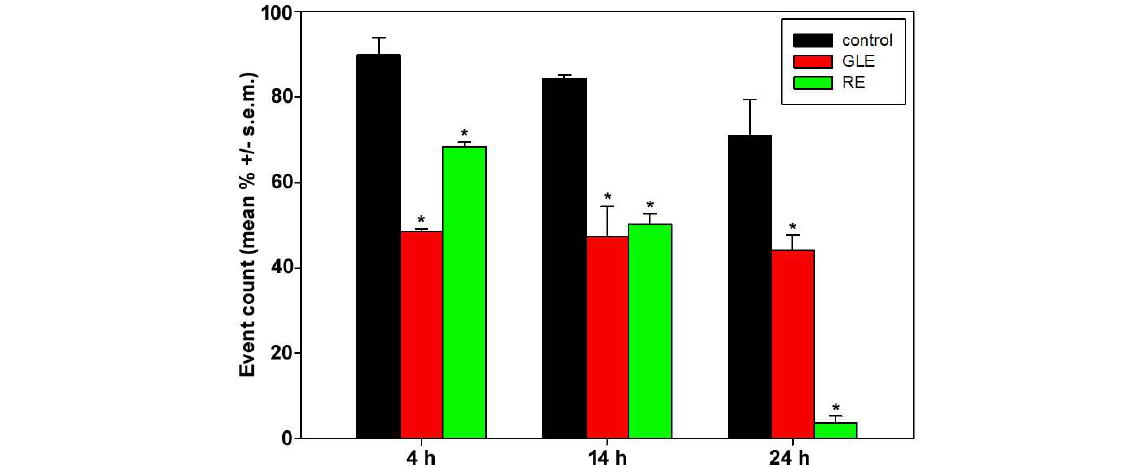
Figure 8. (Upper panel) flow cytometric assays for AVOs in HepG2 cells cultured in control conditions or exposed to the IC 50 of GLE or RE for 4, 14, and 24 h. The plots show the results of representative experiments and the percentages, indicated as the mean ± s.e.m. of three independent experiments, refer to AVO + cells (right quadrants) and AVO - cells (left quadrants). (Lower image) bar graph summarizing the data for control and treated AVO + cells obtained from triplicate experiments. * normality test vs. control